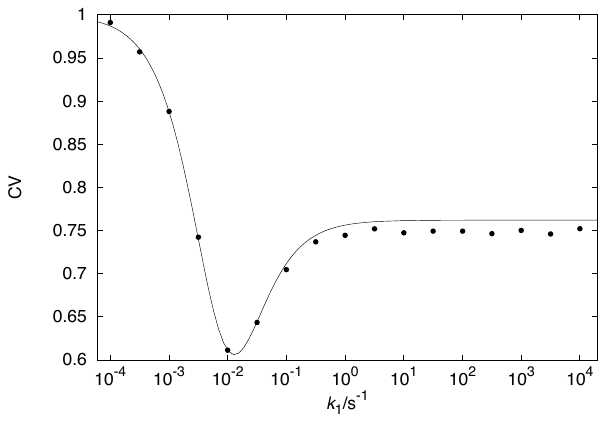
Fig. 9. CV vs k 1 computed from the analytic theory (equation (34), solid line) and from stochastic simulations (dots). The parameters were as follows: k 0 = 0 . 01 s − 1 , k 2 = 10 s − 1 , k 3 = 100 s − 1 , k 4 = 0 . 1 s − 1 , n = 200 and ∆ = 40 . In the stochastic simulations, statistics were collected until 100000 RNAs had been